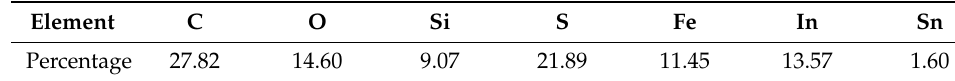
Figure 7. EDX result of iron pyrite film.